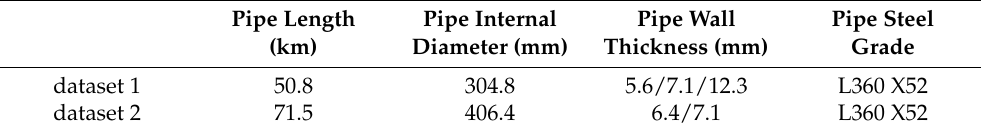
Table 2. Basic information of the pipeline.